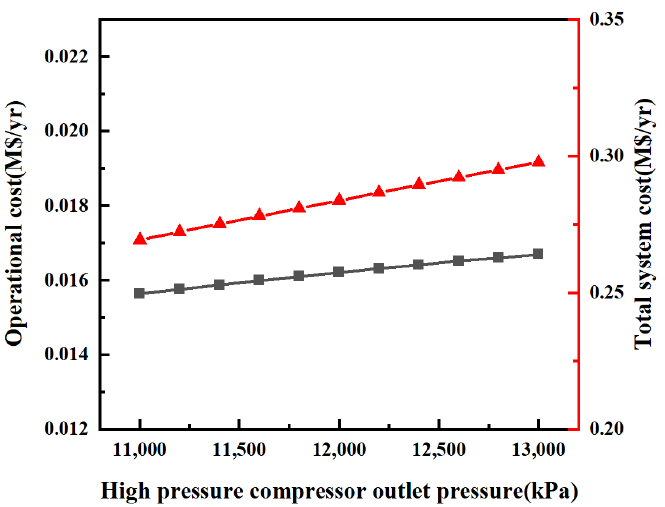
Figure 12. The capital input and maintenance cost of each component of the coupling system varied with the outlet pressure of the high-pressure compressor.